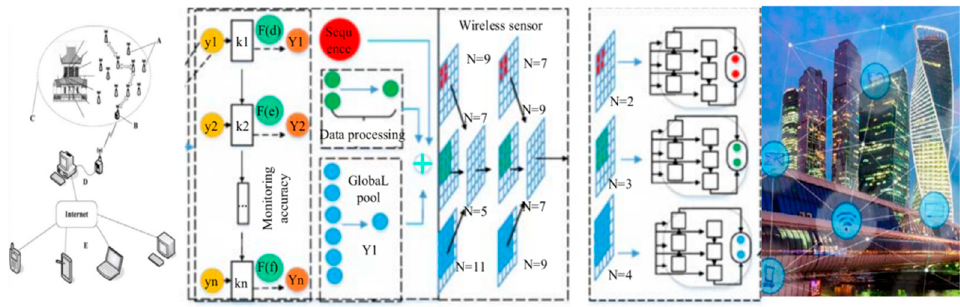
Figure 10. The flow chart of high-rise building deformation monitoring based on remote wireless sensors.